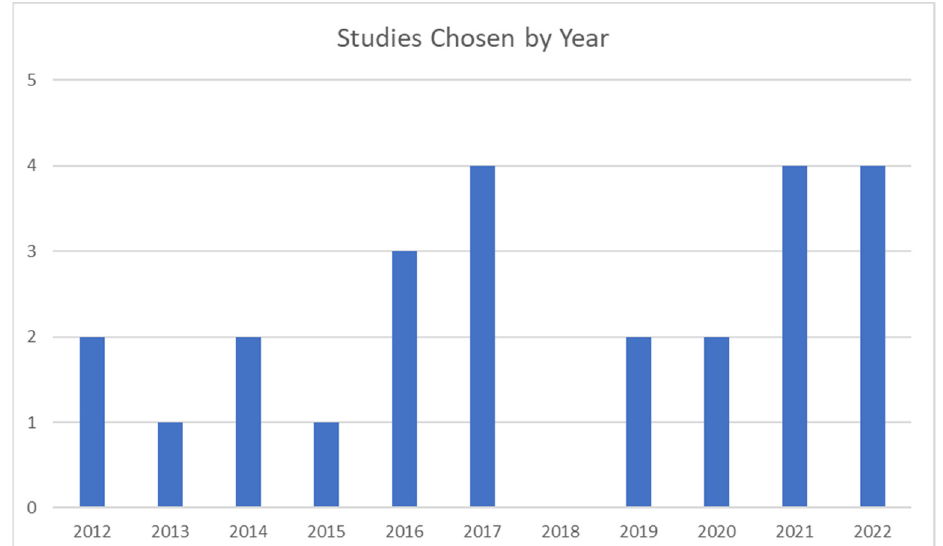
Figure 2. Evolution of studies chosen for analysis.